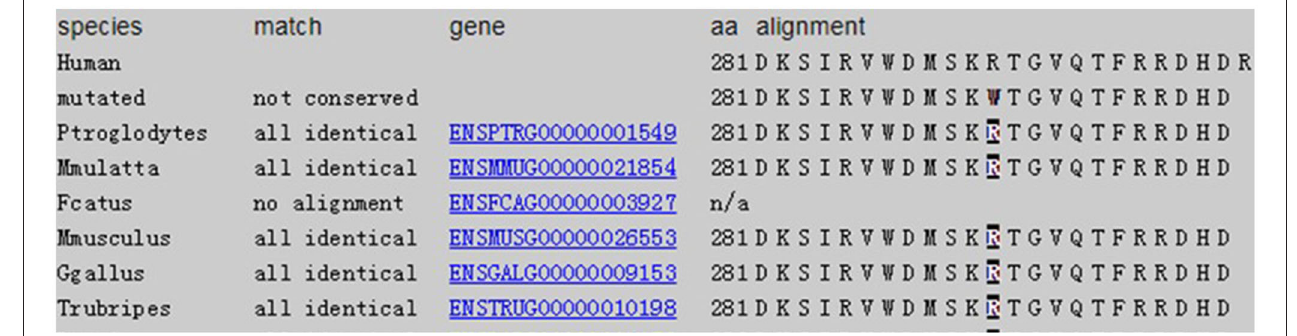
FIGURE 3 | Conservation: amino acids level for non-synonymous changes.